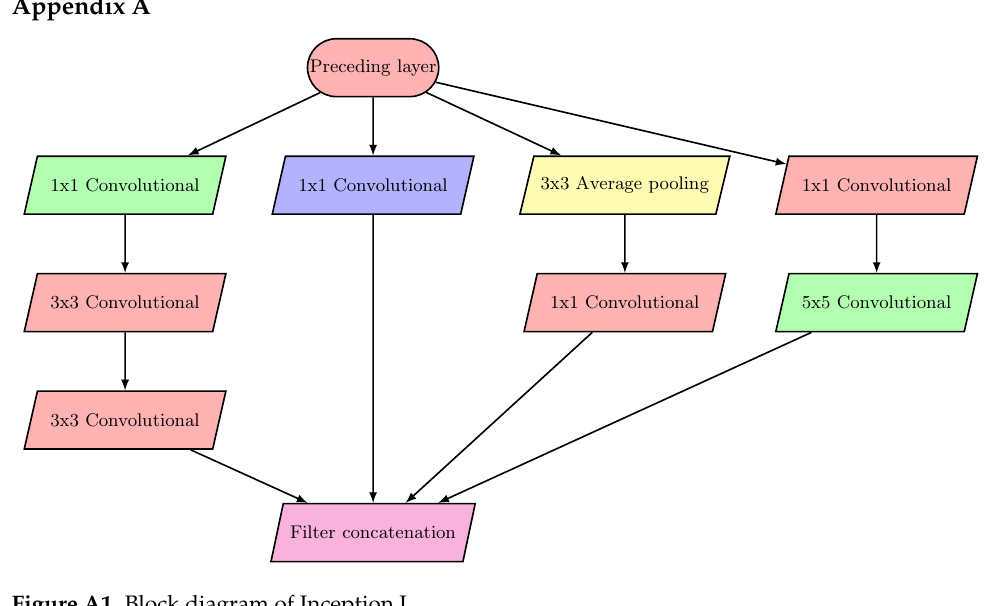
Figure A1. Block diagram of Inception